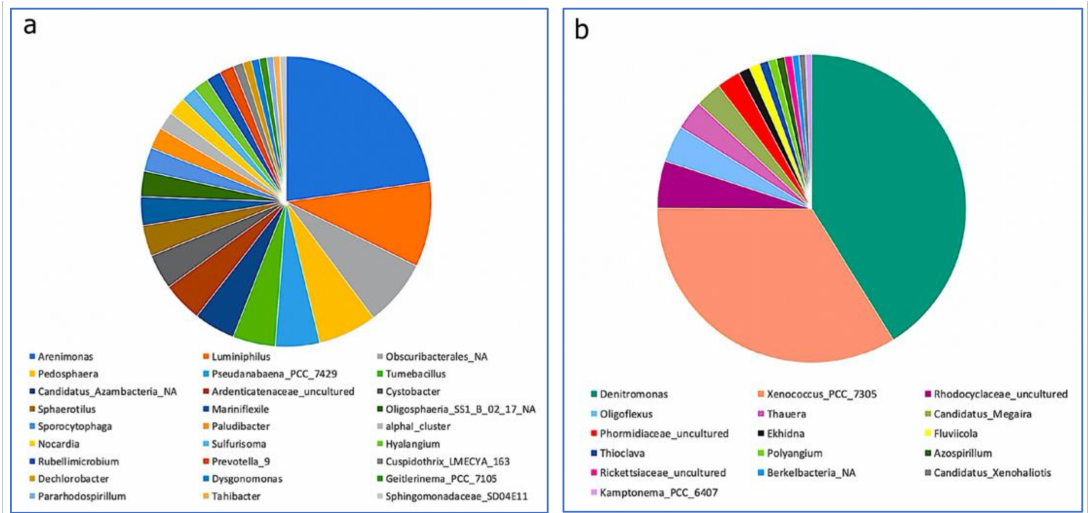
Figure 11. Relative abundance of the specialist genera of bacteria in plant roots bed substrate samples, ( a ) in control CWs and ( b ) in doped CWs collected at the end of the experiment (after 8 weeks). Systems irrigated for eight weeks with Ribeira de Joane water not doped (control) or doped with PCP. Only genera with abundance > 1% are